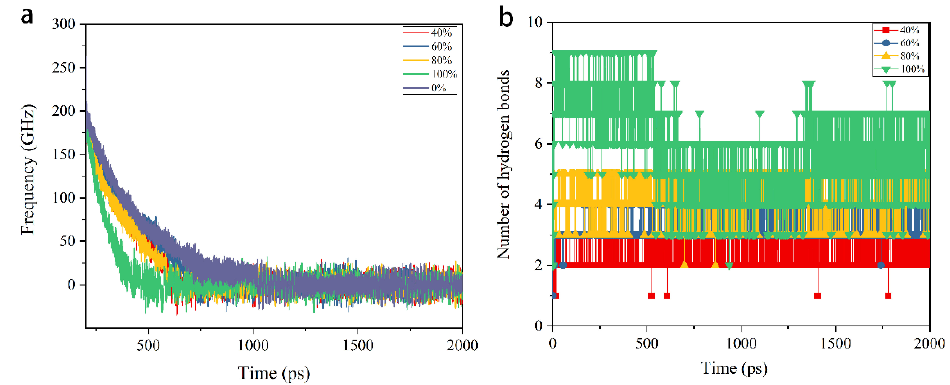
Figure 3. ( a ) The rotation frequency of rotor during braking process when pristine CNTs, CNTs with 40%, 60%, 80%, 100% grafted hydroxyl groups are applied. ( b ) The number of hydrogen bonds when 40%, 60%, 80%, 100% hydroxyl groups are grafted, respectively.